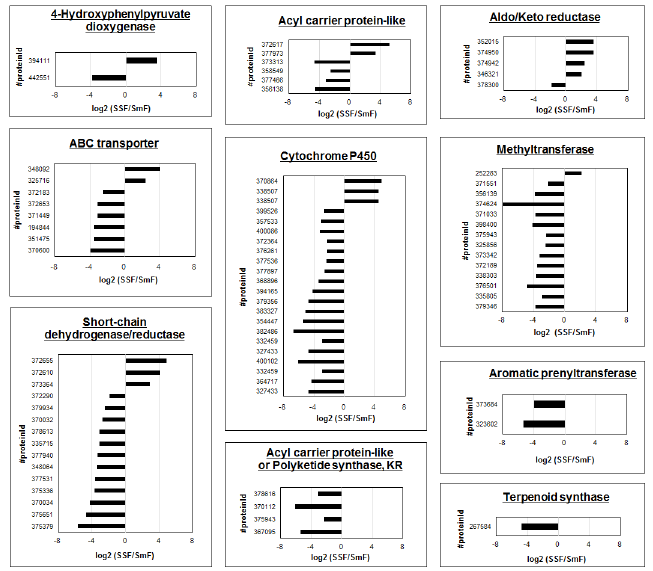
Fig 5. Transcript abundance values of DEGs in secondary metabolism. Abundance values (log2 SSF/ SmF) and transcripts with significant variations (log2 SSF/SmF abundance greater than 1) are shown.